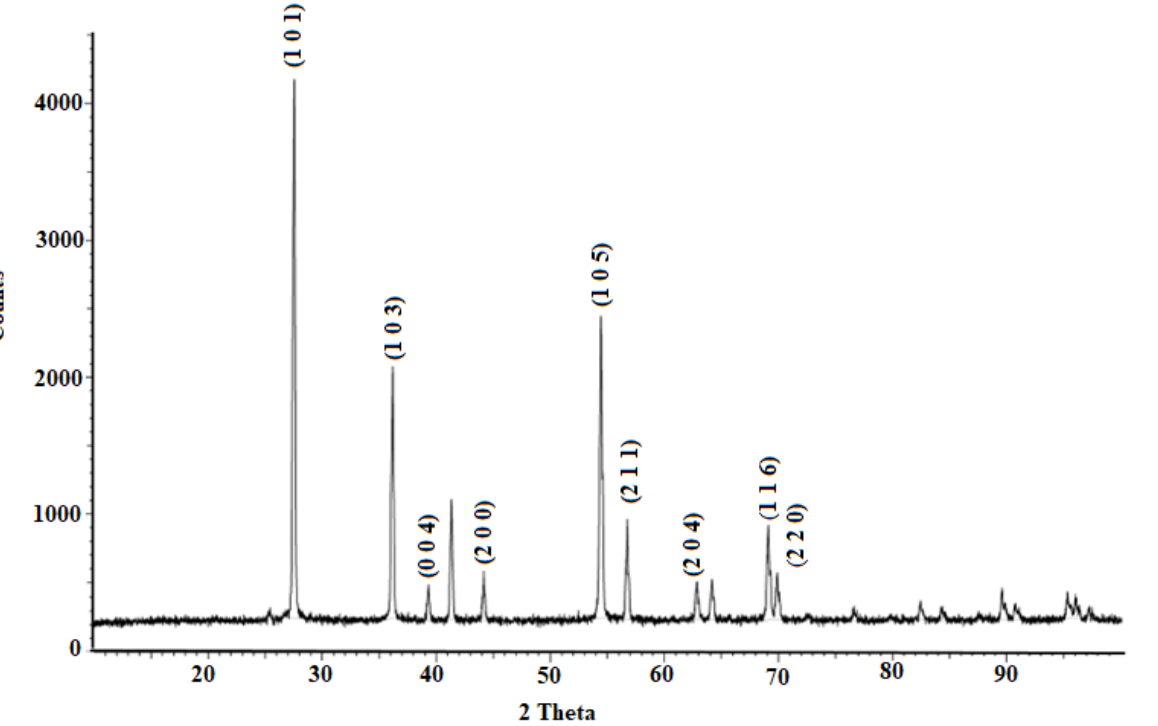
Figure 1. X ‐ ray diffraction patterns of green TiO 2 nanoparticles. Figure 1. X-ray diffraction patterns of green TiO 2